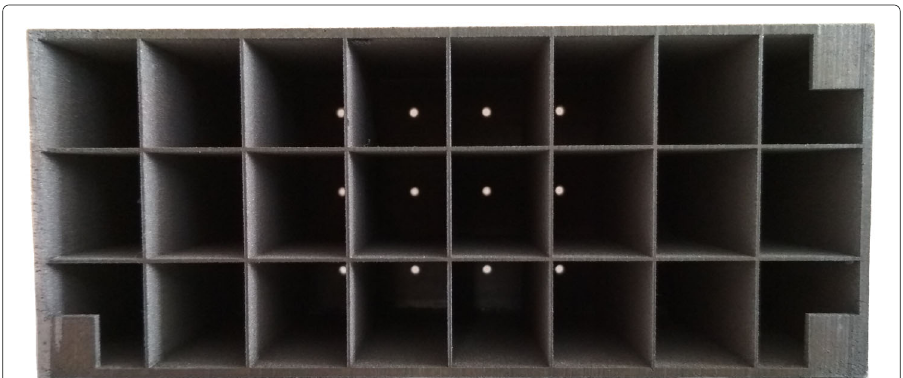
Fig. 18 Backside view of the real collimator. Each pinhole yields an activity patch according to its compartment. These compartments define the field of view of the pinholes. Some light-passing pinholes can be seen in the middle